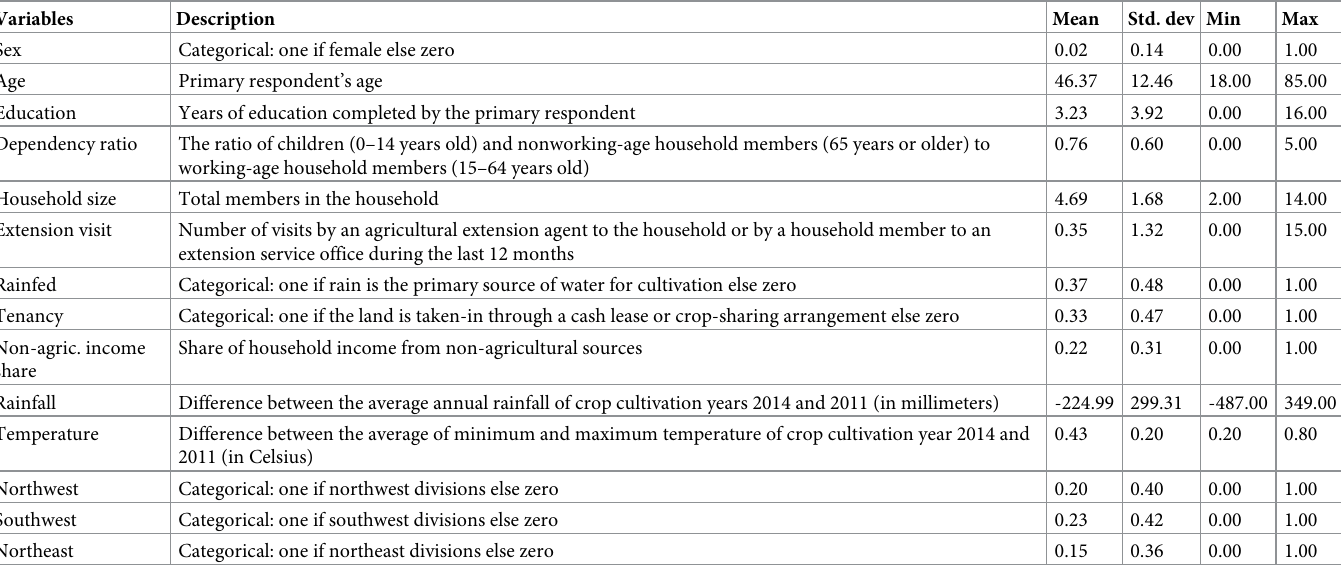
Table 4. Control variables and descriptive statistics.